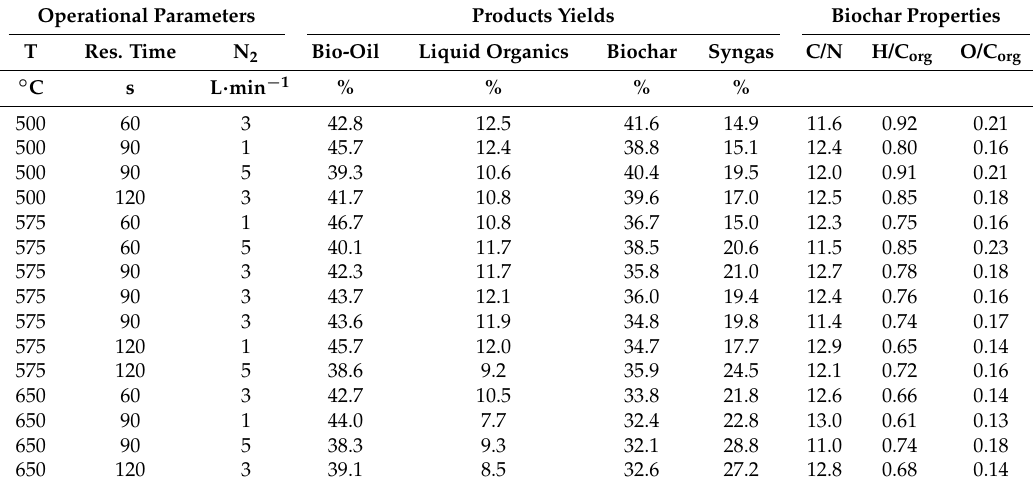
Table A3. Pyrolysis of SFPM—Experimental data.